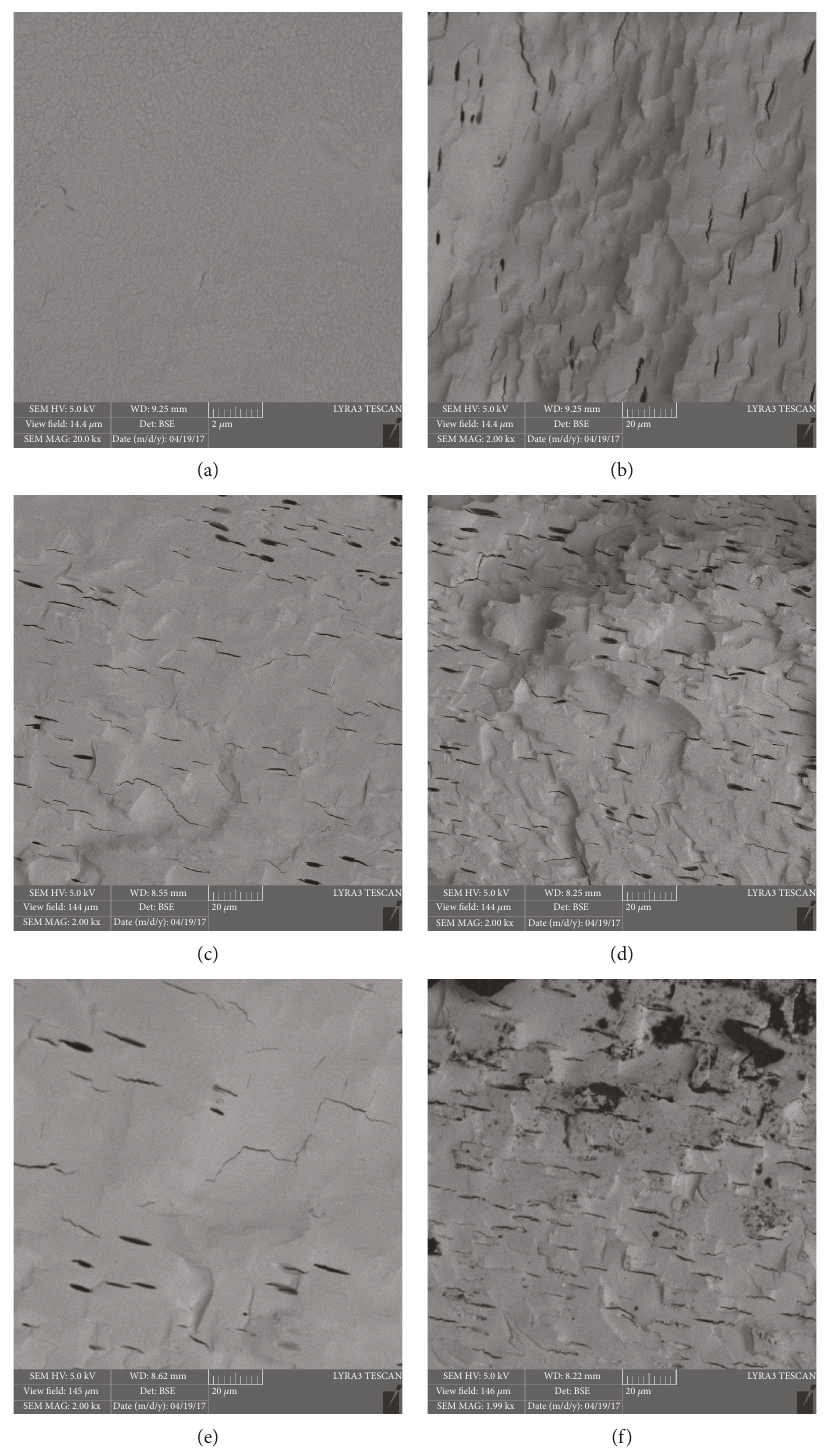
Figure 4: SEM micrographs of PVA/PEG nanocomposites at graphene loadings of (a) 0%, (b) 0.1%, (c) 0.2%, (d) 0.3%, (e) 0.5%, and (f)